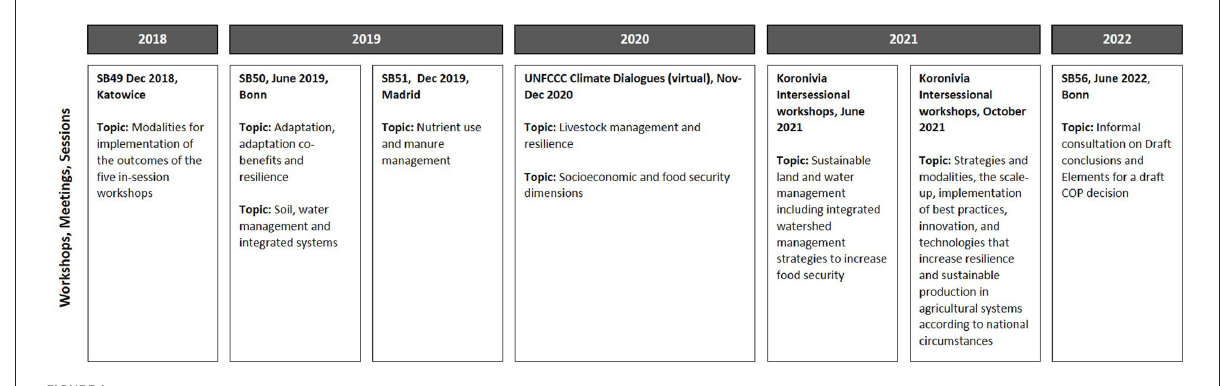
FIGURE1 Timeline of Koronivia workshops, adapted from Drieux et al. (2021) Koronivia roadmap. Written submissions were invited through an open consultation process prior to each